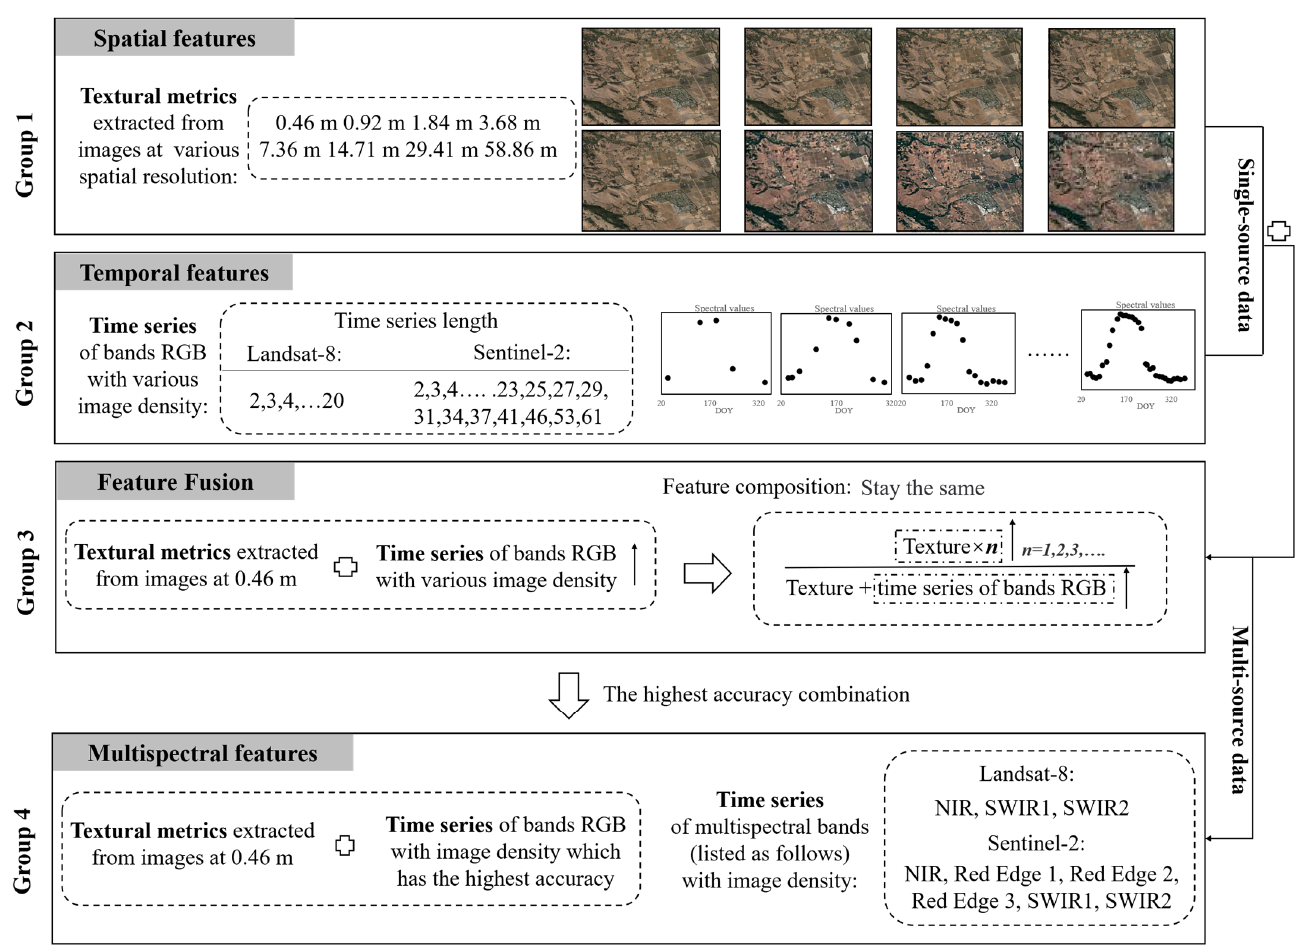
Figure 6. Design experiment: four groups of classified inputs.